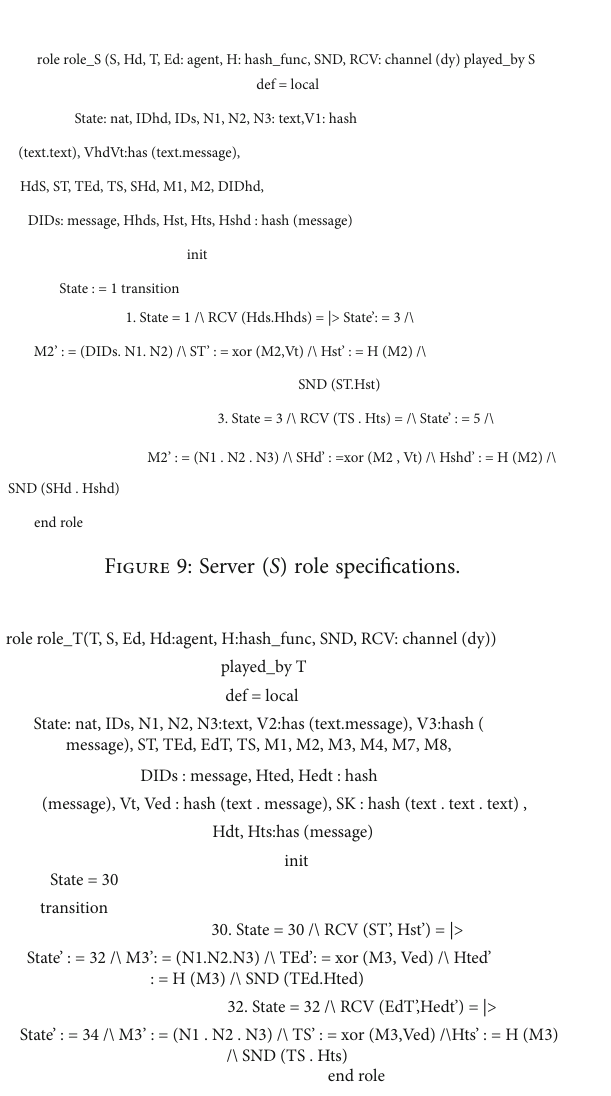
Figure 8: Handheld device role speci fi cations.